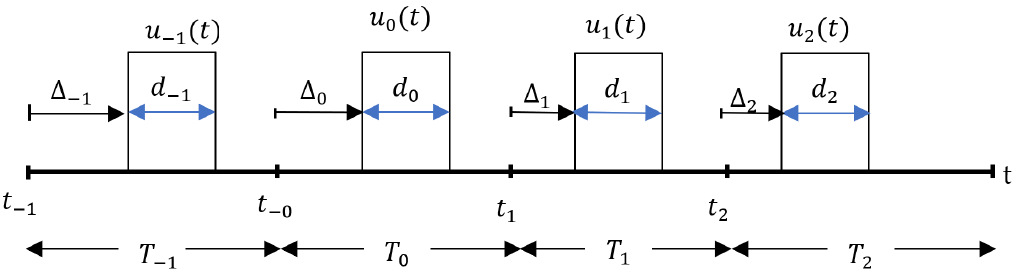
Figure 1. Random switching signal.